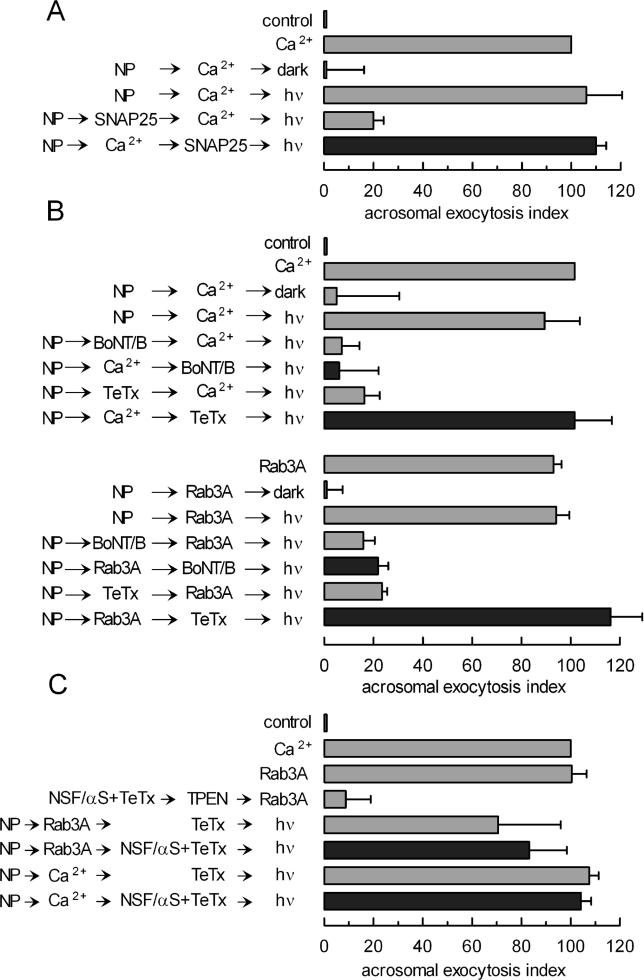
SNAREs Reassemble in Loose Complexes That Are Resistant to NSF/α-SNAP before the Efflux of Intra-Acrosomal Ca2+
(A) Permeabilized spermatozoa were loaded with 10 μM NP-EGTA-AM (NP) for 15 min at 37 °C to chelate intra-acrosomal Ca2+. AE was then initiated by adding 10 μM free Ca2+ (Ca2+). After 15 min incubation at 37 °C to allow exocytosis to proceed to the intra-acrosomal Ca2+-sensitive step, 800 nM recombinant SNAP25 (SNAP25) was added to compete with endogenous SNAP25. Intra-acrosomal Ca2+ was replenished by photolysis of NP-EGTA-AM (hν), and the samples were incubated for 5 min to promote exocytosis (NP→Ca2+→SNAP25→hν, black bar). Sperm were then fixed and AE was measured as described in Materials and Methods.(B) Permeabilized spermatozoa were loaded with 10 μM NP-EGTA-AM (NP) for 15 min at 37 °C. AE was then initiated by adding 10 μM free Ca2+ (Ca2+) or 300 nM Rab3A (Rab3A). After 15 min incubation at 37 °C, 100 nM neurotoxin recognizing VAMP (BoNT/B and TeTx) was added to the tubes to assess whether the SNAREs had reassembled in loose trans complexes sensitive to BoNT/B but not to TeTx. After 15 min incubation at 37 °C, intra-acrosomal Ca2+ was replenished by photolysis of NP-EGTA-AM (hν), and the samples were incubated for 5 min to promote exocytosis (NP→Ca2+/Rab3A→neurotoxin→hν, black bars). Sperm were then fixed and AE measured as described in Materials and Methods.(C) To assess whether NSF/α-SNAP can disassemble loose trans SNARE complexes, permeabilized sperm treated as in (B) were incubated with TeTx in the presence of 310 nM NSF and 500 nM α-SNAP (NP→Ca2+/Rab3A→NSF/αS+TeTx→hν, black bars).Several controls were included in (A), (B), and (C) (grey bars): background AE in the absence of any stimulation (control); AE stimulated by 10 μM free Ca2+ (Ca2+) or 300 nM Rab3A (Rab3A); inhibitory effect of NP-EGTA-AM in the dark (NP→Ca2+/Rab3A→dark) and the recovery upon illumination (NP→Ca2+/Rab3A→hν); inhibitory effect when SNAP25 was present throughout the incubations (NP→SNAP25→Ca2+→hν); inhibitory effect when the neurotoxins were present throughout the incubations (NP→neurotoxin→Ca2+/Rab3A→hν); and the effect of NSF/α-SNAP on SNARE complexes in unstimulated sperm (NSF/αS+TeTx→TPEN→Rab3A→hν). The data were normalized as described in Materials and Methods (mean ± SEM). Statistical analysis is provided in Table S7.